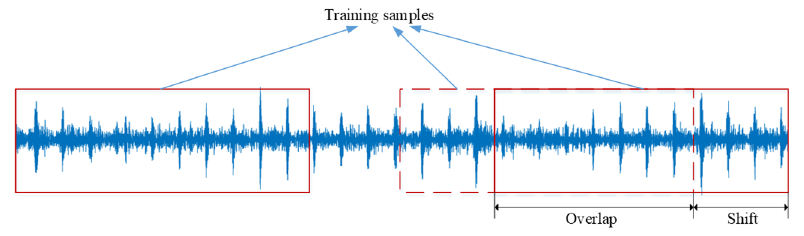
Figure 5. Data preprocessing.